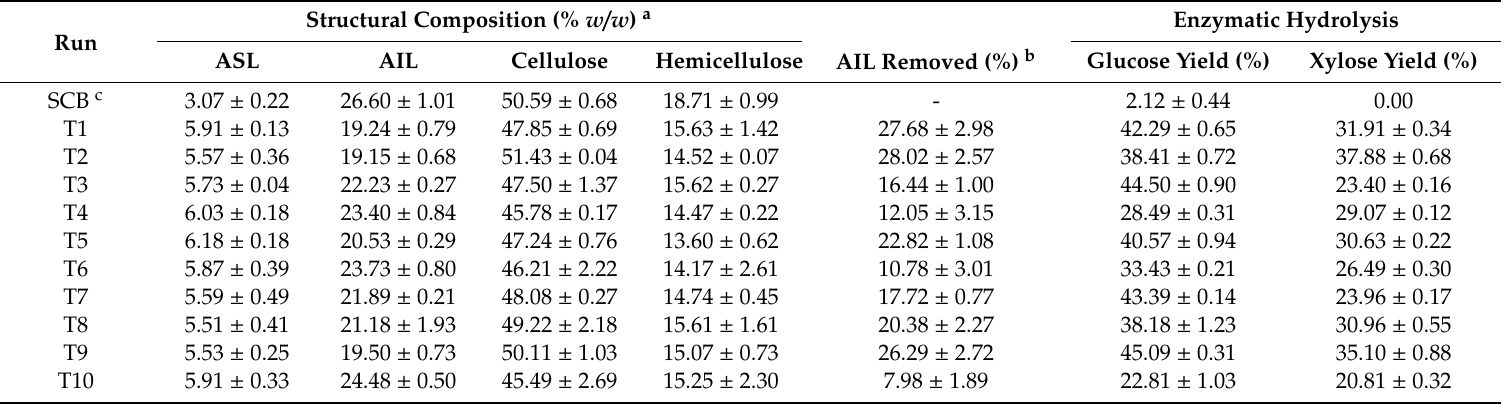
Table 2. Structural composition and enzymatic hydrolysis performance of un- and pretreated